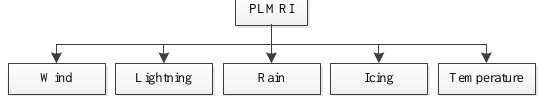
Figure 4 The decision hierarchy for PLMRI